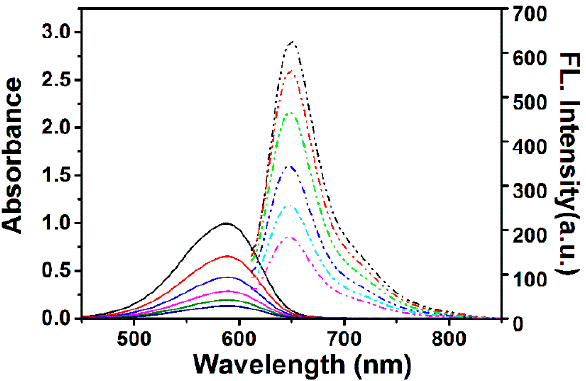
Figure 1. The absorption spectra and fluorescence emission spectra of QICY (0–20 μ M) in ul- trapure water ( λ ex = 590 nm).